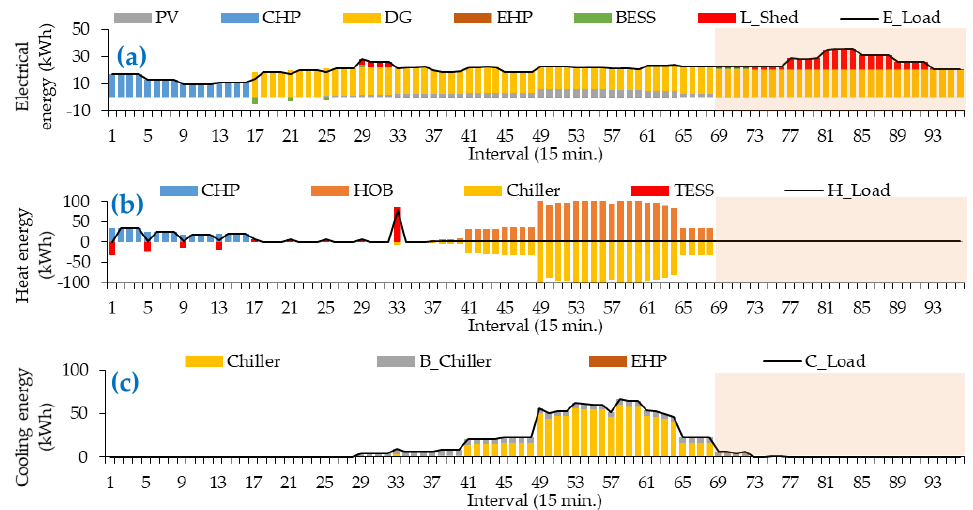
Figure 14. Energy balancing: ( a ) Electrical Energy; ( b ) Heat Energy; ( c ) Cooling Energy.